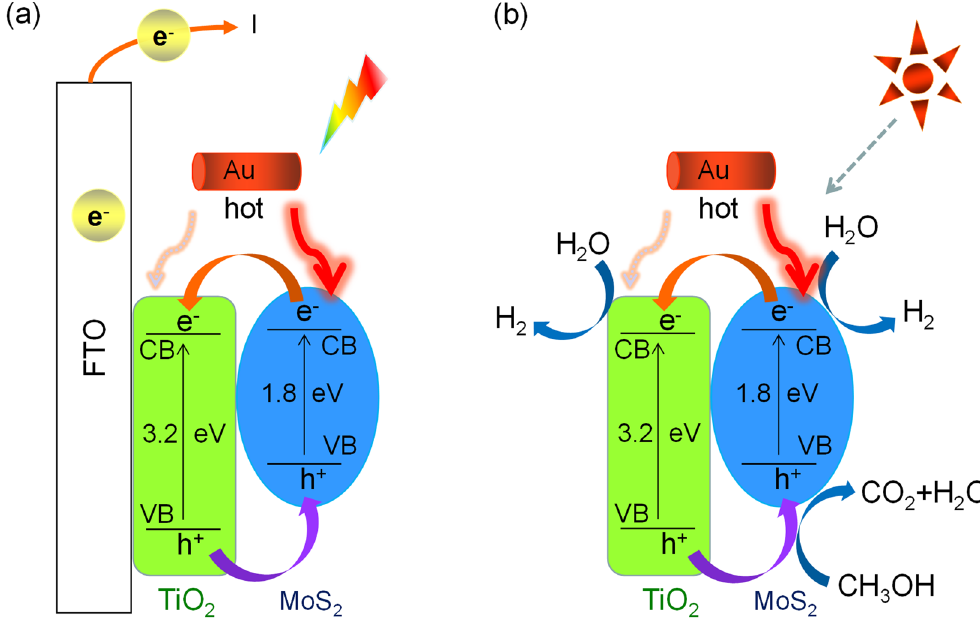
Figure 7. Schematic illustration of energy band structure and electron-hole separation of (MoS 2 -TiO 2 )/Au nanocomposites in PEC cell ( a ) and in photocatalytic hydrogen generation ( b